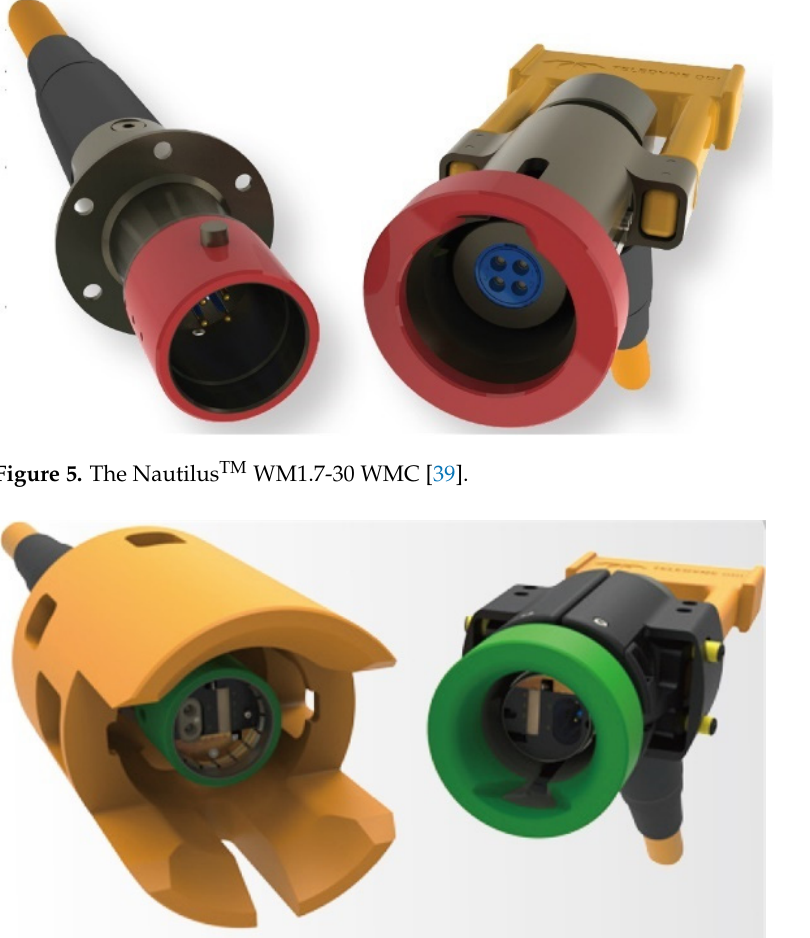
Figure 5. The Nautilus TM WM1.7-30 WMC [39].